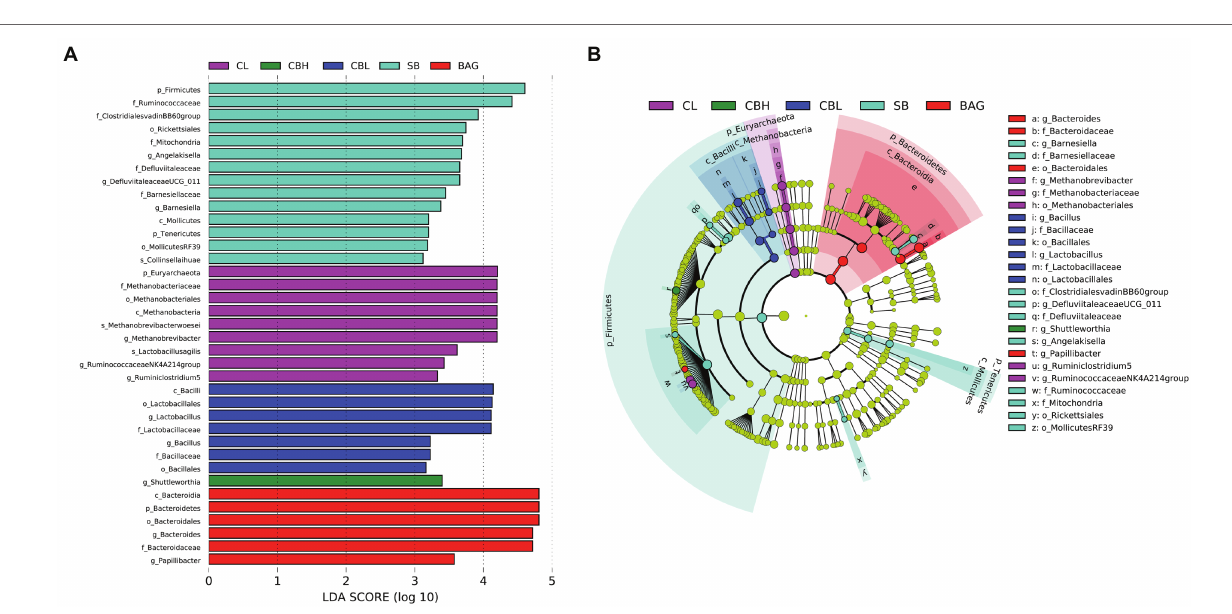
FIGURE 4 | Linear discriminant analysis (LDA) effect size (LEfSe) analysis (LDA > 3.0, p < 0.05) of intestinal microbes. The prefixes “p_,” “c_,” “o_,” “f_,” “g_,” and “s_” represent the annotated level of phylum, class, order, family, genus, and species. (A) LDA and (B)